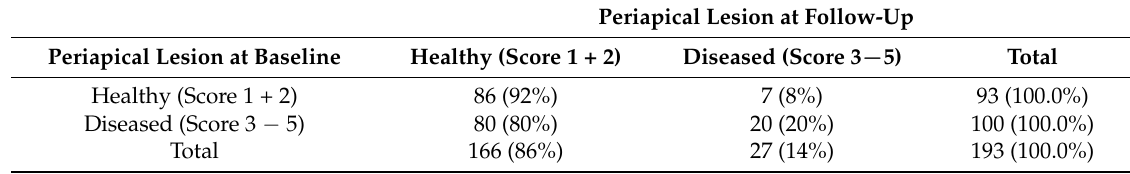
Table 2. Periapical lesion at baseline and at follow-up. Periapical Lesion at Follow-Up